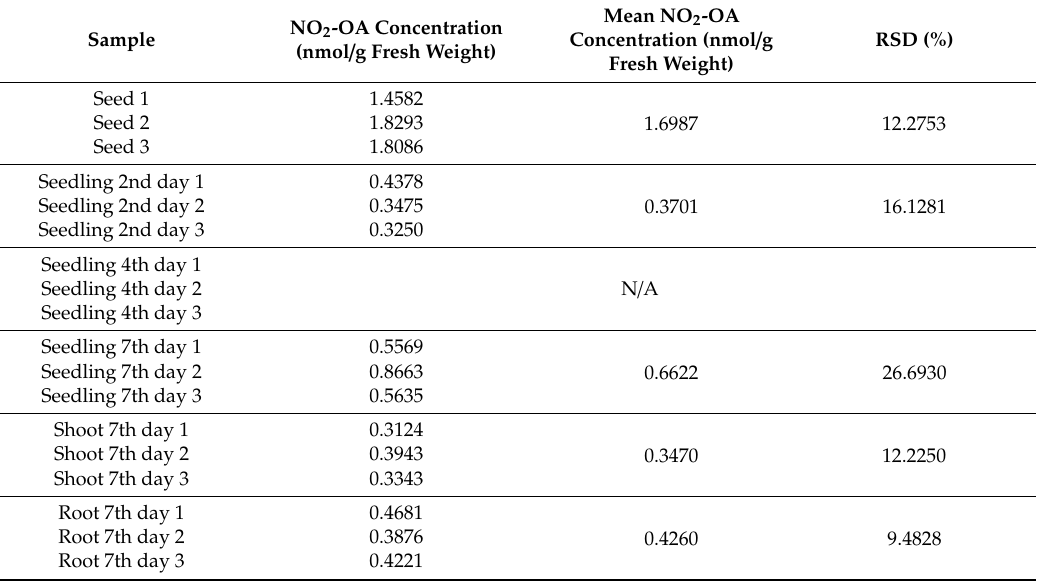
Figure 2. Calibration line of NO 2 -OA standard. Axis X shows the range of injected NO 2 -OA amount (ng) from working solutions, axis Y shows the mean area under curve (AUC) of the working solutions. Table 1. Concentrations of nitro-oleic acid (NO 2 -OA) in B. napus seeds and di ff erently developed seedlings. N / A (not available) indicates data under the detection limit. Samples were injected three times, the precision (RSD, %) of the sample measurements ranged between 0.1348–3.9822 RSD%. The precision between the parallel samples ranged between 9.4828–26.6930